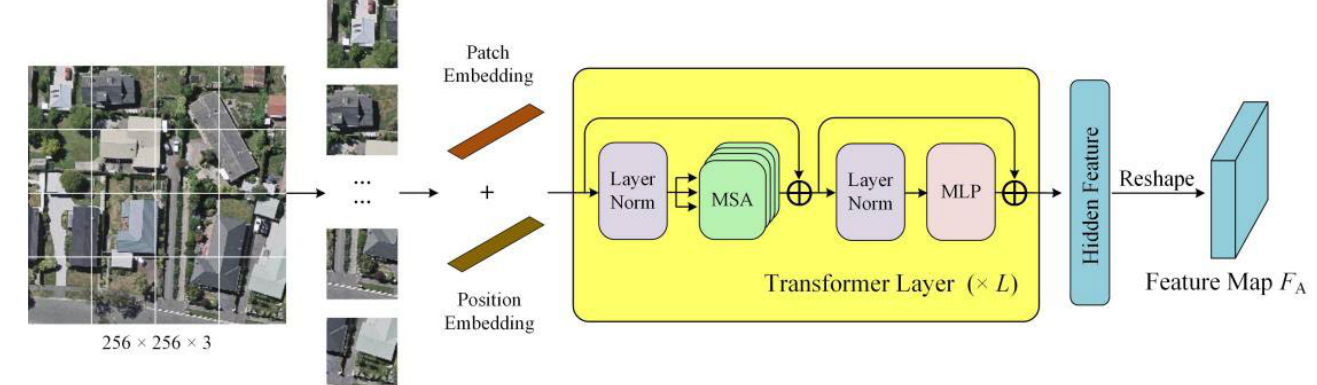
Figure 3. Transformer module.